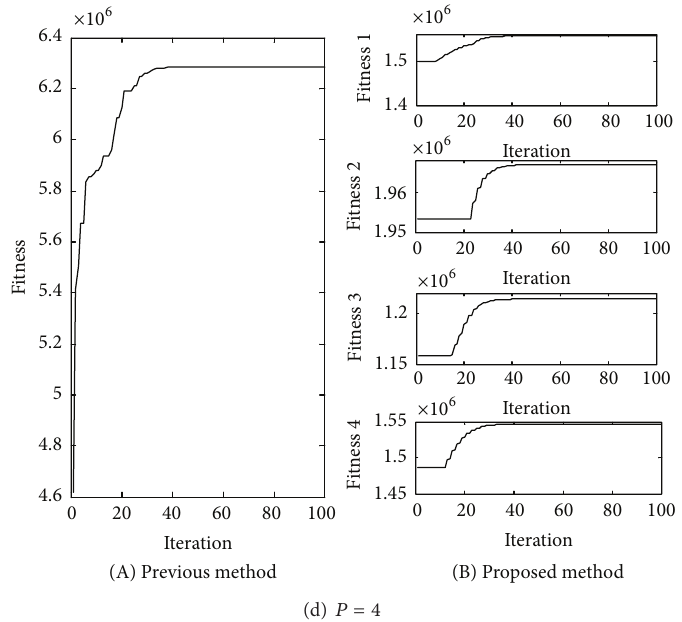
Figure 4: The fitness curves of two methods.